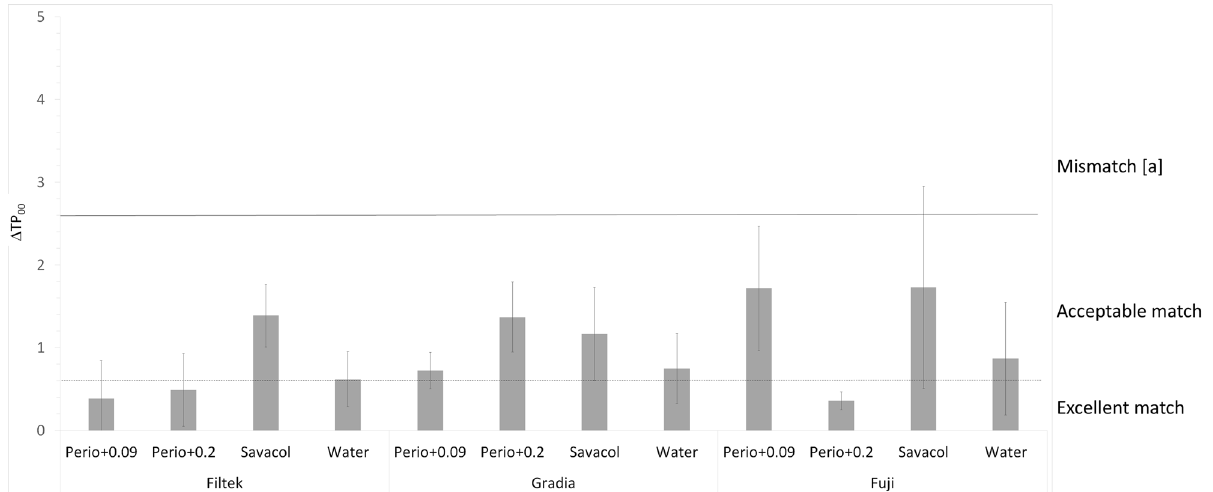
Figure 2. CIEDE2000 translucency parameter differences (ΔTP 00 ) compared with literature data for visual thresholds for tooth-coloured restorative materials 26 . Excellent match (ΔTP 00 ≤ 0.6), acceptable match (0.6 < ΔTP 00 ≤ 2.6), mismatch type [a] (2.6 < ΔTP 00 ≤